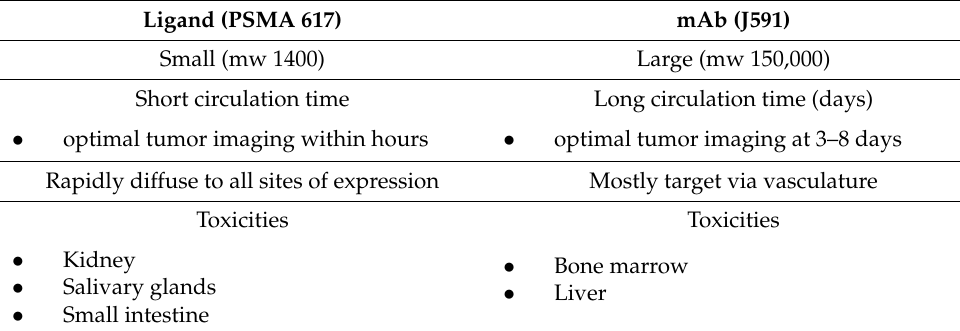
Table 4. Differences between mAb and